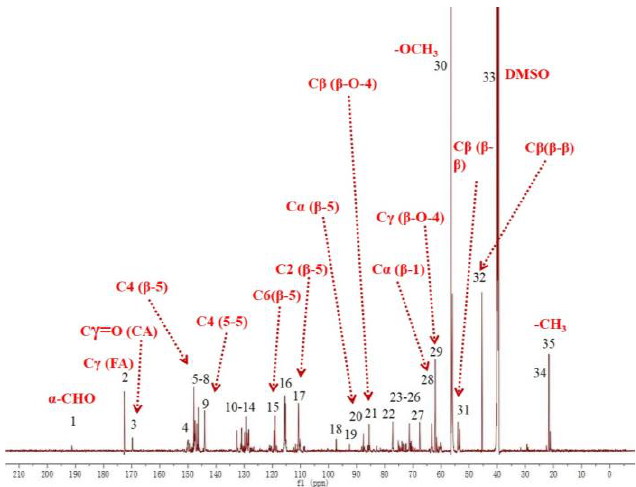
Figure 1. 13 C-NMR spectrum of DHP-G.